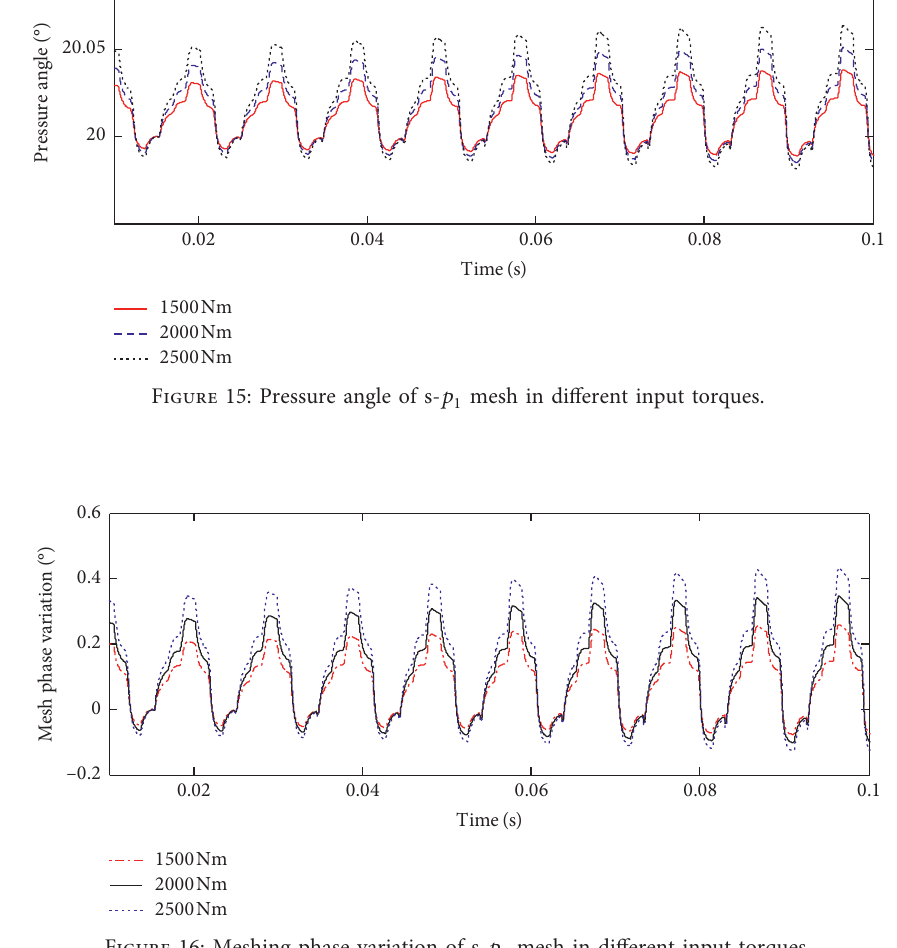
mesh in different input 1